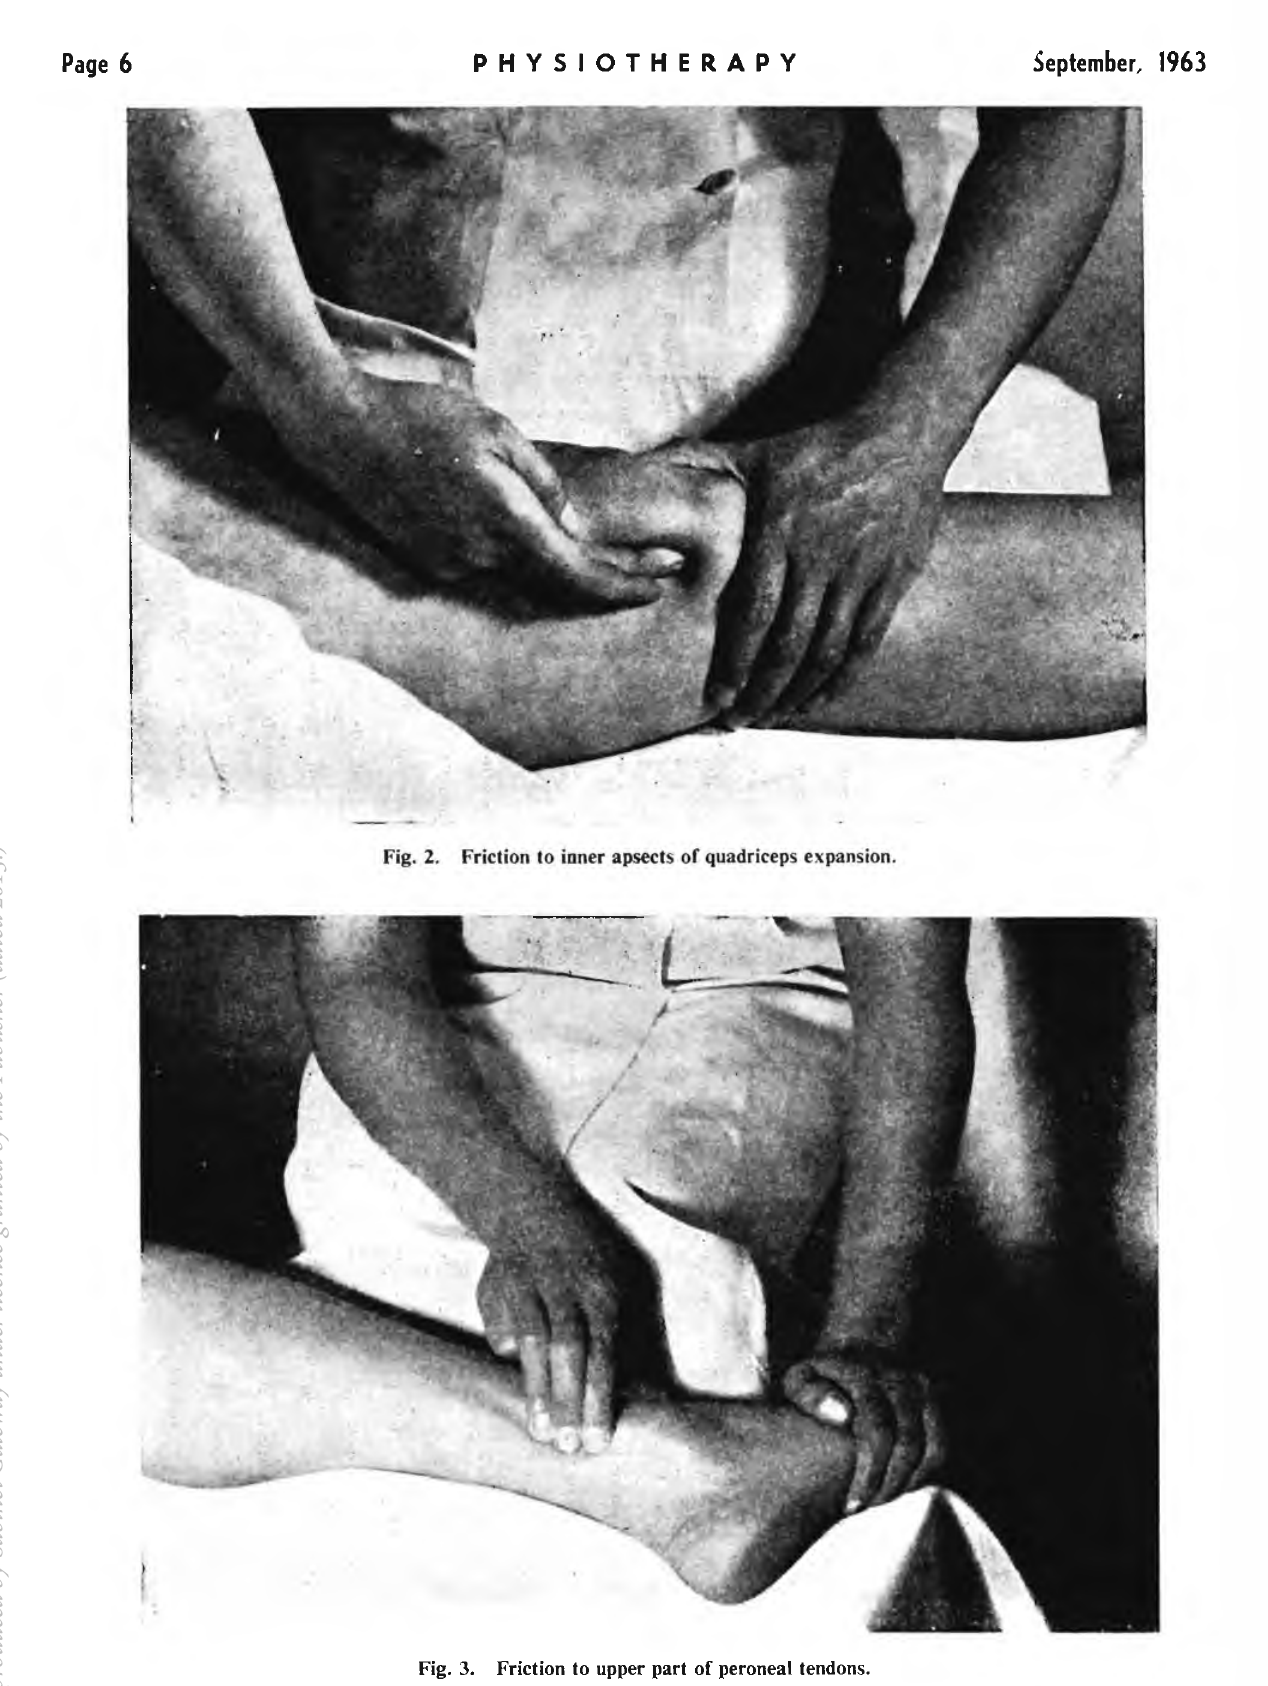
Fig. 3. Friction to upper part of peroneal